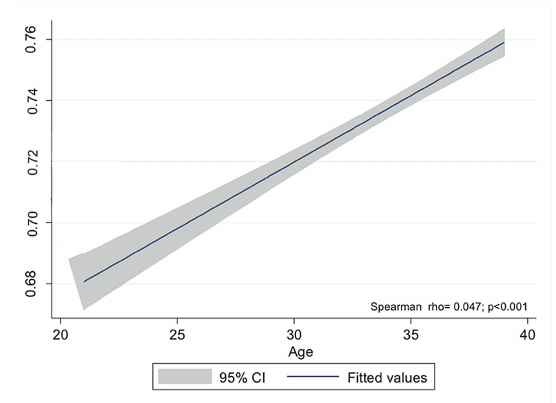
Figure 3 - Correlation between PSA values and ages.